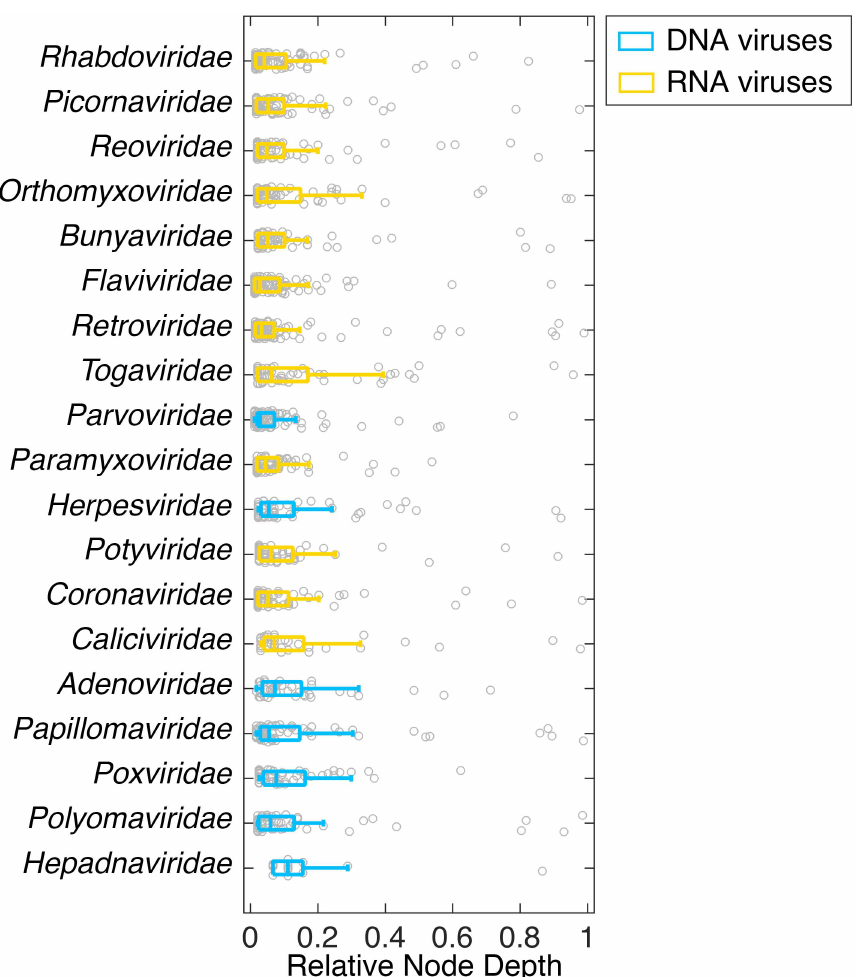
can be interpretedas the occurrence of host-switching events at the tips of the phylogenetic tree, whereasa relativenode depth close to 1 suggests host-switching events at the root of the phylogenetic tree. A range of DNA (blue) and RNA (yellow)virus families are shown. For ease of interpretation virus families are rankedas in Fig